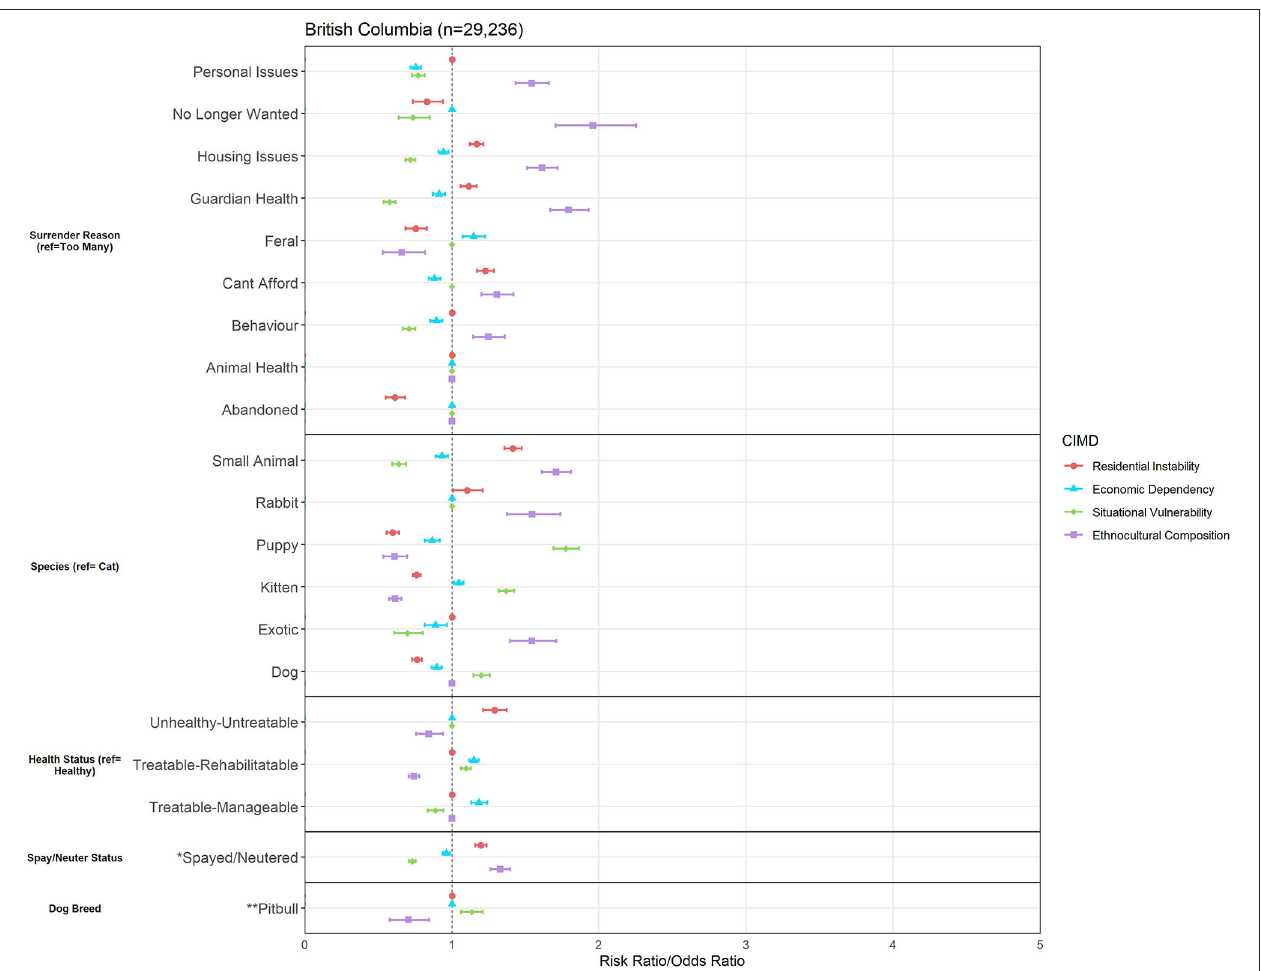
FIGURE 1 | Association between Canadian Index of Multiple Deprivation (CIMD) factors and owner surrender variables across British Columbia ( n = 29,236). Results of logistic regression models for shelter variables by increasing CIMD factor scores are shown. Data are presented by risk ratios and their 95% confidence interval (bars); p < 0.05 when 95% confidence interval does not cross the vertical dotted line. Non-significant results are represented by a risk ratio of 1 with no CI. A risk ratio > 1 suggests an increased risk of that shelter variable category as you increase in deprivation, while a risk ratio < 1 suggests a reduced risk. *denotes data from dogs, cats, kittens, and puppies only ( n = 25, 075) and is represented in odds ratios (and 95% CI). **Denotes data from dogs and puppies only ( n = 6,516) and is represented in odds ratios (and 95%